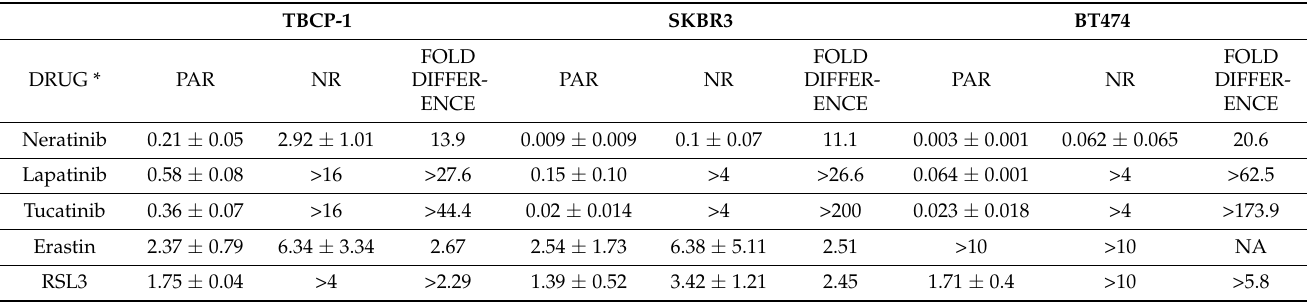
responses to laminin-511 (LM-511) were decreased compared to TKI-sensitive parental cells (Figure 1D,E). Adhesion to and migration towards fibronectin were unchanged. Table 1. Neratinib resistance is associated with cross-resistance to other HER2-targeting TKIs and ferroptosis inducers.